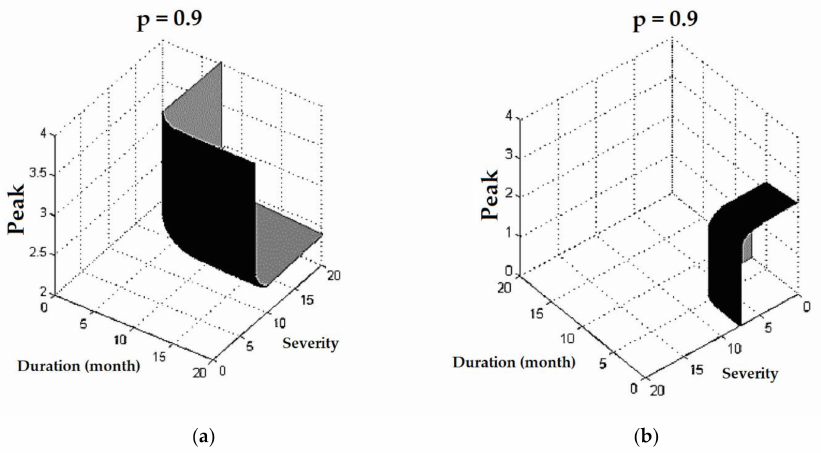
= 0.9 ( a ) and P ∧ = 0.9 DSP DSP